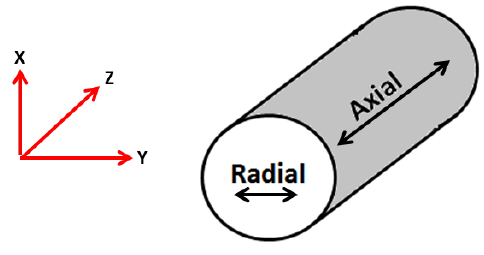
Figure 4. Reference system used to describe bar microstructures.